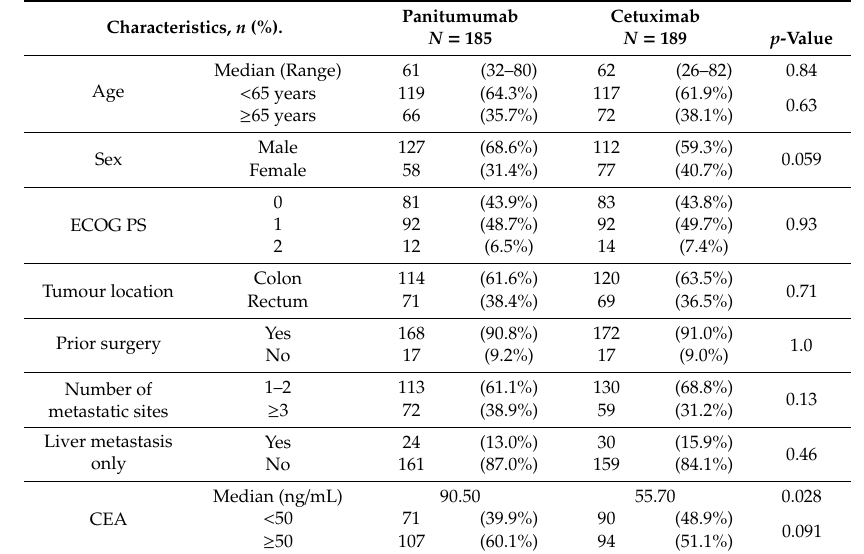
Figure 1. Study population. The panitumumab or cetuximab monotherapy (ASPECCT)was a phase-III trial of panitumumab versus cetuximab monotherapy. The WJOG6510G was a randomised phase-II trial of panitumumab plus irinotecan, versus cetuximab plus irinotecan. Abbreviations: Bev, bevacizumab; Cmab, cetuximab; Pmab, panitumumab. Table 1. Patient characteristics.